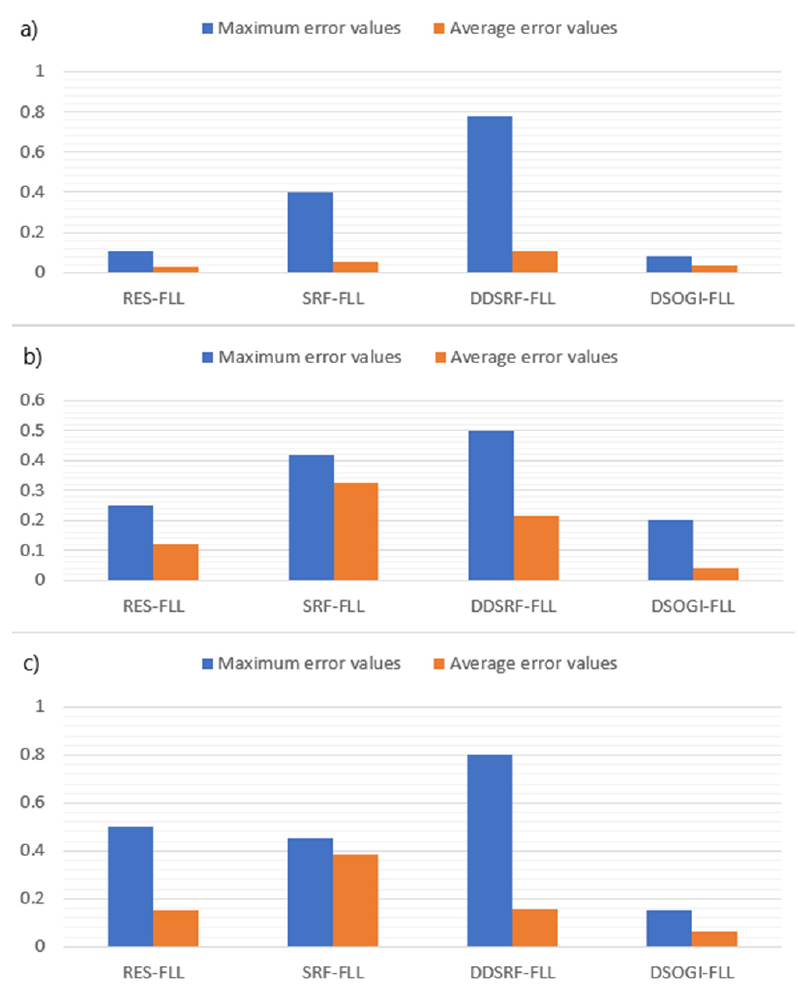
Figure 16. Comparison of maximum and average error values for ( a ) frequency swing, ( b ) harmonics injection, and ( c ) type B short-circuit.